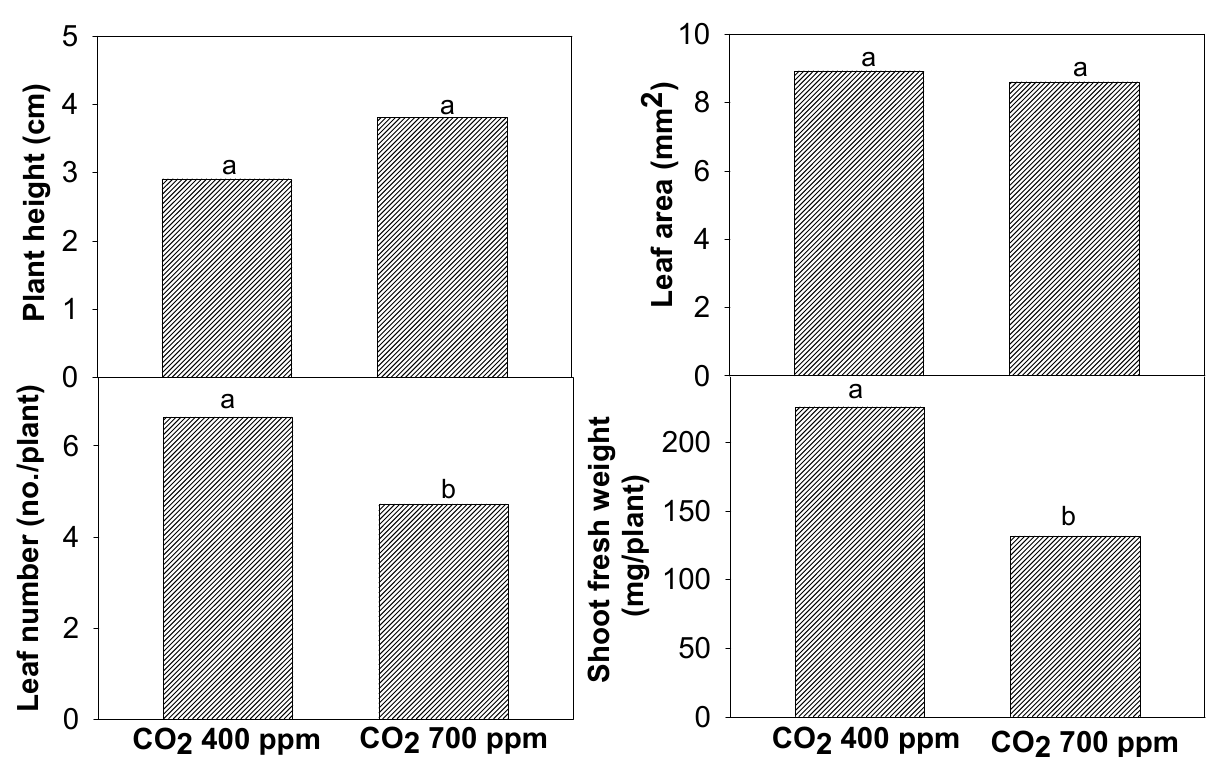
Figure 5. Plant height, leaf number, leaf area, and shoot fresh weight of A. patulus grown under 400 or 700 ppm CO 2 in growth chambers. The parameters were measured 17 days after seeding. Means within bars followed by the same letters are not significantly different at the 5% level according to Duncan’s Multiple Range Test.